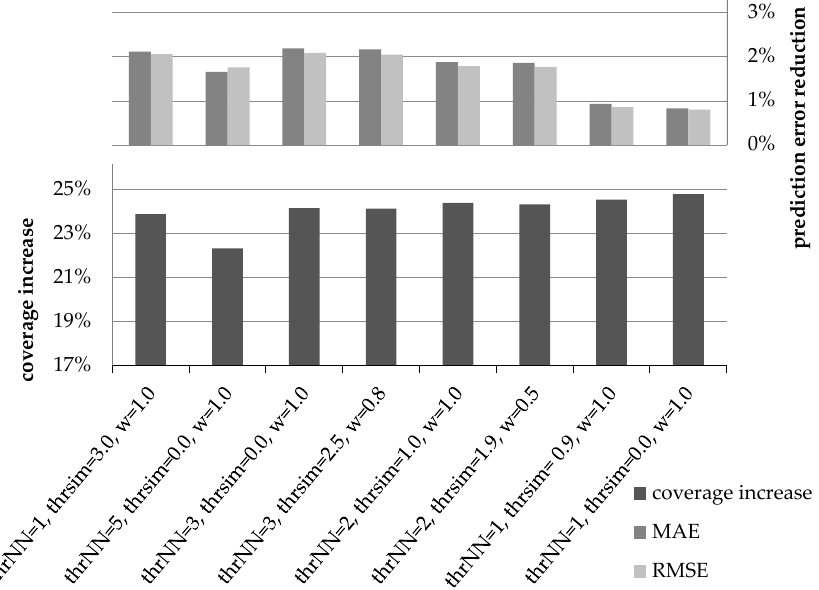
Figure 2. Prediction error reduction and coverage increase under different parameter value combinations, when using the CS as the similarity metric.